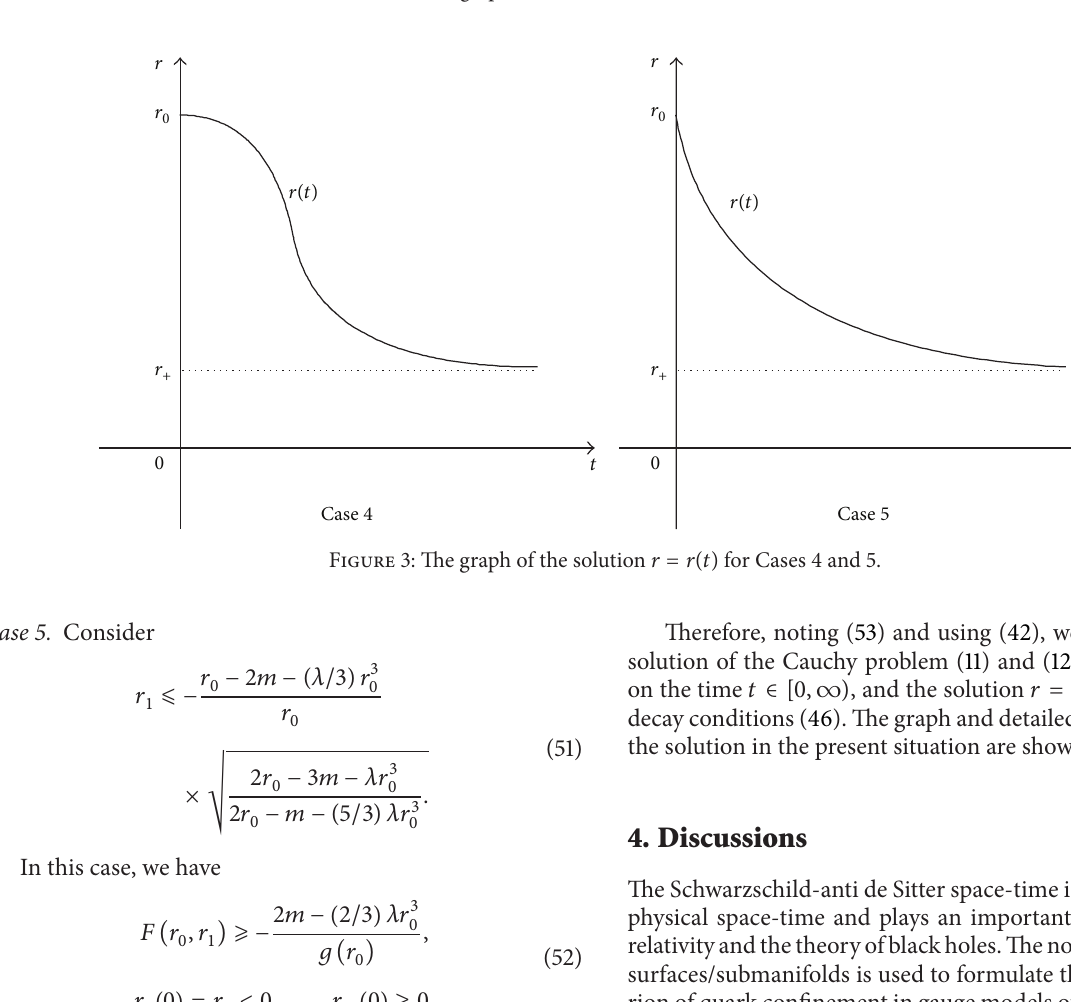
Figure 2: The graph of the solution 𝑟 = 𝑟(𝑡) for Cases 2 and 3.